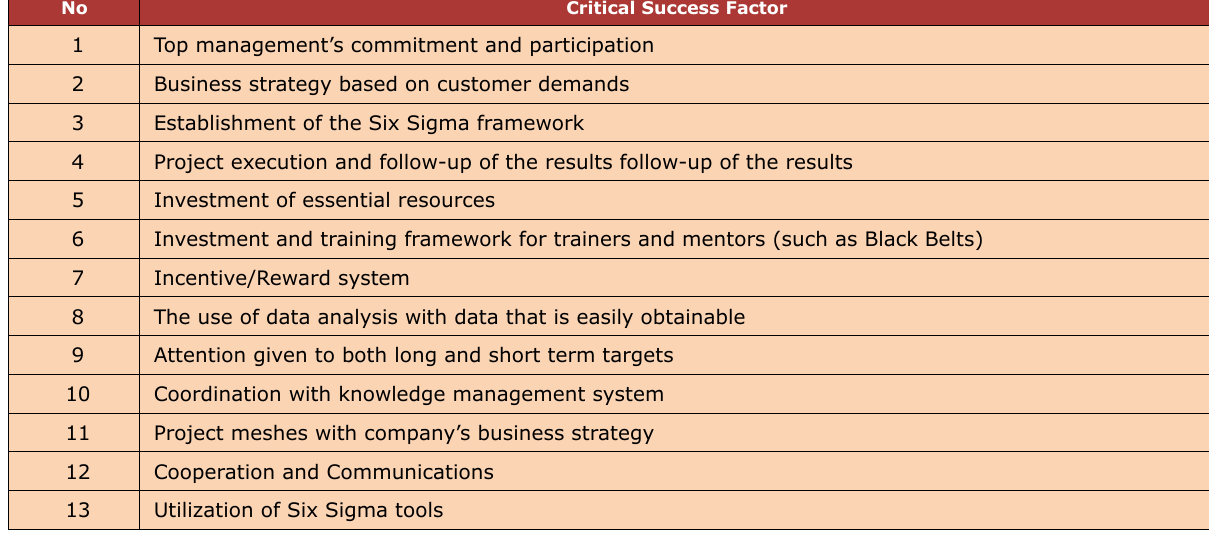
Table 1. List of Critical Success Factors studies (Ho et al.,